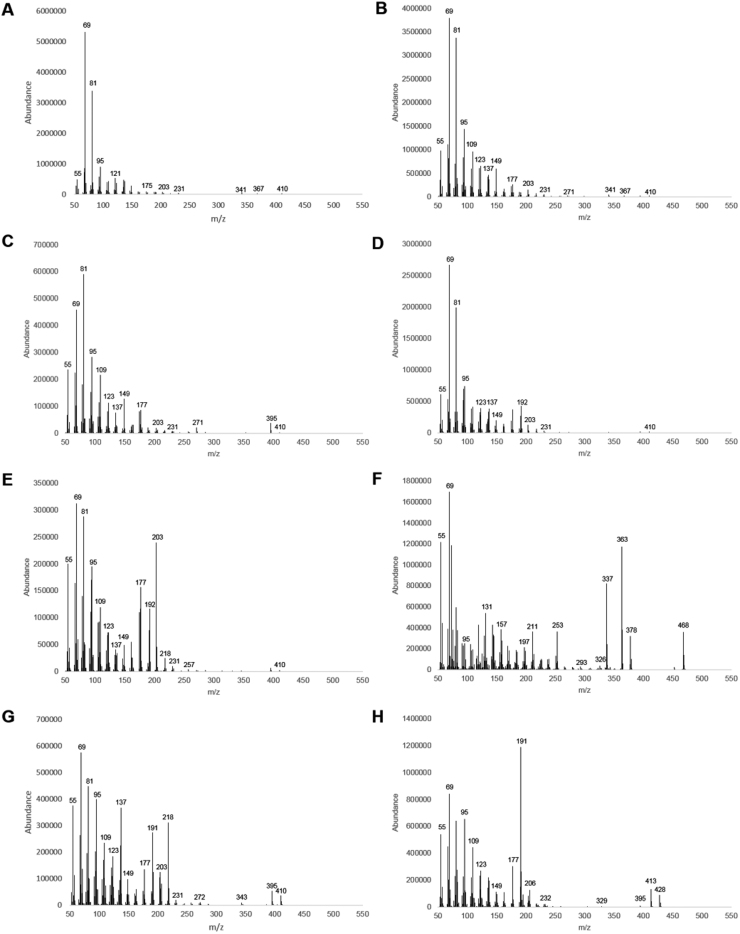
Mass spectra of the compounds shown in the chromatograms in Fig. 4. A: squalene, B: 3-deoxyachilleol, C: presumably bicyclic squalene derivative, D: 8α-hydroxypolypoda-13,17,21-triene, E: (+)-ambrein F: ergosterol-TMS ether G: 14β-hydroxyonocera-8(26)-ene, H: onoceranoxide.